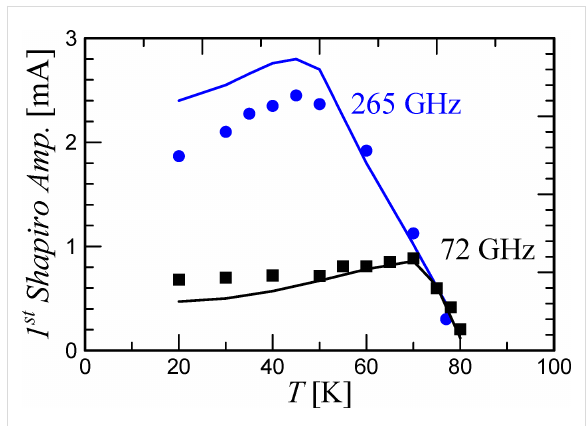
Figure 3: The dependence of the first Shapiro step amplitude on the temperature for 72 and 265 GHz radiation at a constant power. The dots are the experimental values, the lines are the theory for the tem- peratures at which the measurements were conducted.